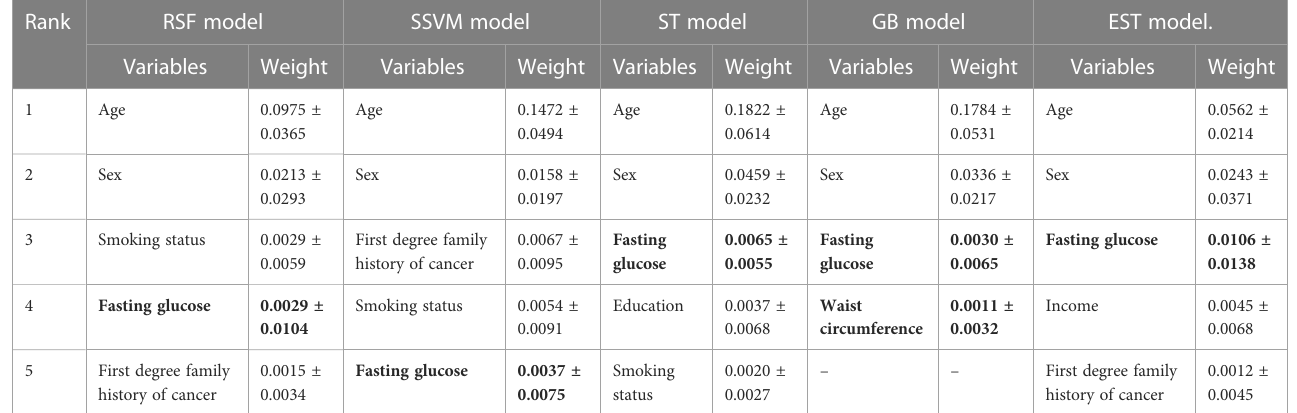
TABLE 3 Top 5 most important predictors for incident GI cancer based on the ML